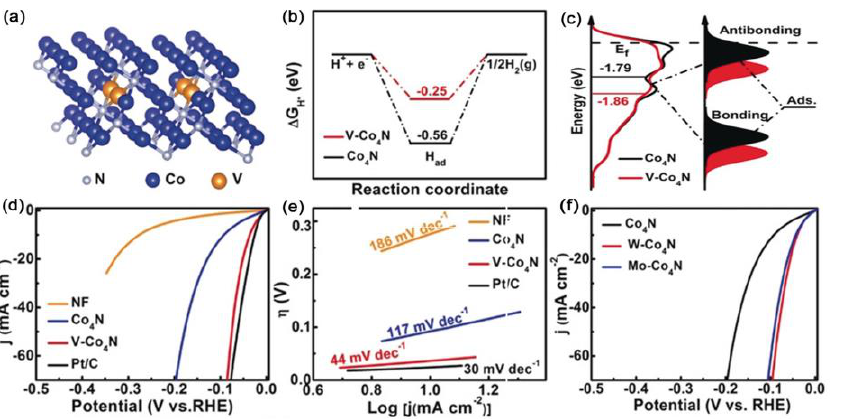
Figure 8. ( a ) The geometric configuration of V − Co 4 N (111) with V atoms replacing the subsurface Co atoms. ( b ) Free − energy diagram for the HER. ( c ) The density of states (DOS) plots as well as the corresponding schematic illustration of bond formation between the catalyst surface and the adsorbates. ( d ) LSV curves and ( e ) the Tafel slopes of the prepared samples. ( f ) The LSV curves of Co 4 N, W − Co 4 N, and Mo − Co 4 N. Reproduced with permission from ref. [108]. Copyright 2018,